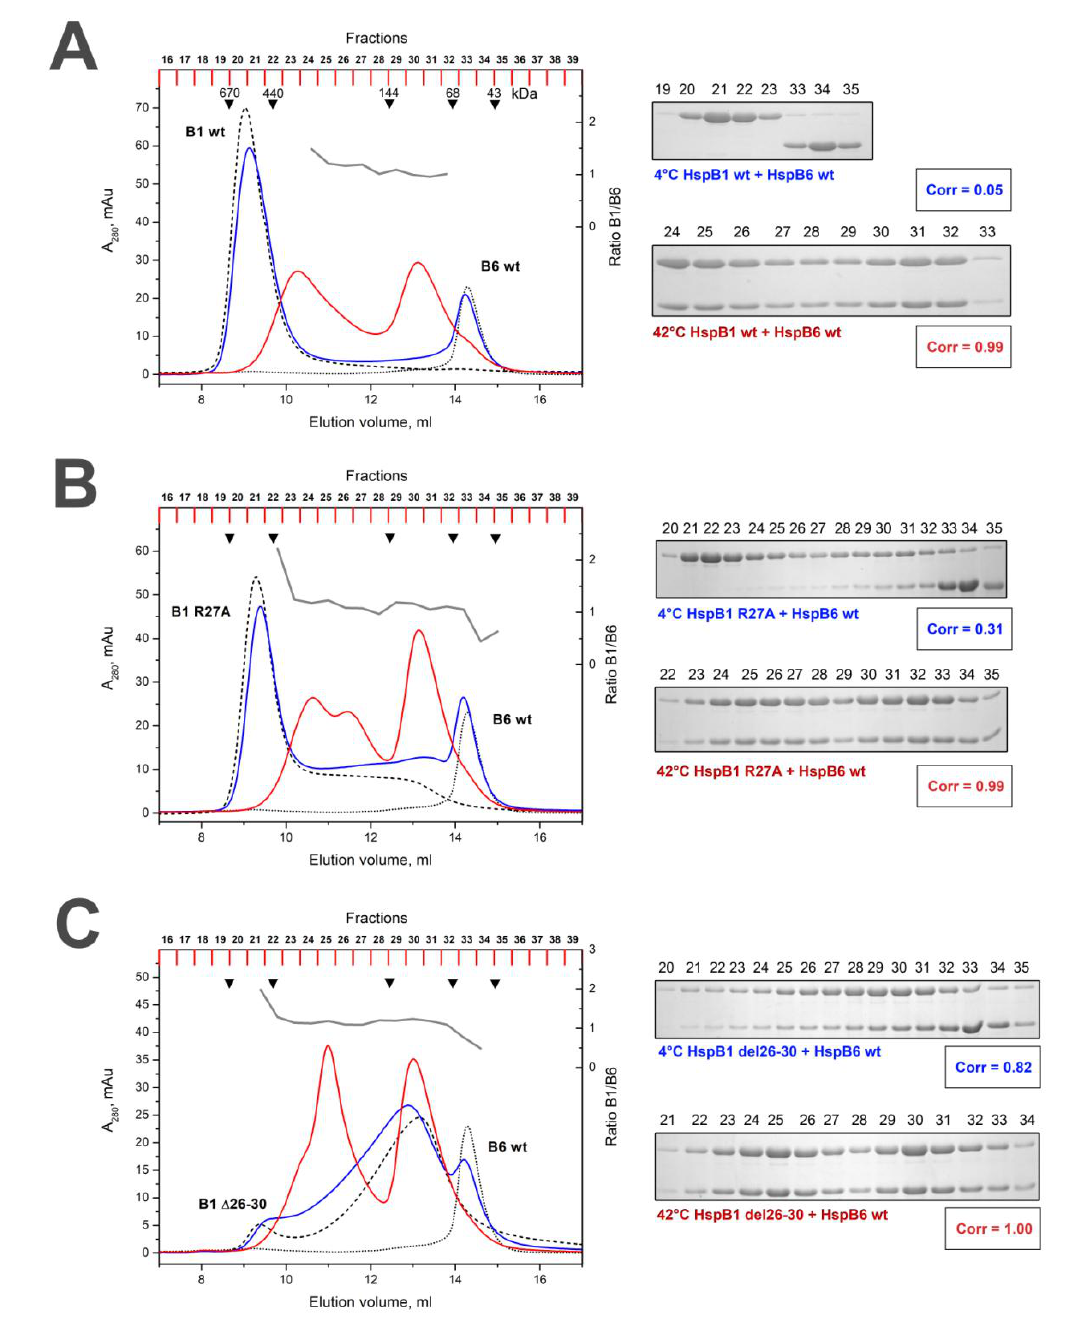
Figure 3. Size-exclusion chromatography of the WT HspB1 (A), its R/A (B) and Δ (C) mutants and their mixtures with the WT HspB6. Elution profiles of isolated HspB6 is shown as black dotted line, that of isolated HspB1 or its mutants by black dashed line. Elution profile of the mixture of HspB1 species and HspB6 preincubated at low temperature is shown as solid blue line and that of the corresponding mixture preincubated at elevated temperature is shown as solid red line. Molar ratio HspB1/HspB6 (grey solid line) in corresponding fractions obtained after chromatography of preheated sample is indicated on the right ordinate. Protein composition of fractions obtained after chromatography of HspB1/HspB6 mixture preincubated at low (labeled blue) or high (labeled red) temperature are presented on inserts. Correlation coefficient (Corr) is indicated under each electrophoregram. Numbers above tracks correspond to the fractions number. Apparent molecular weights are indicated by arrows.